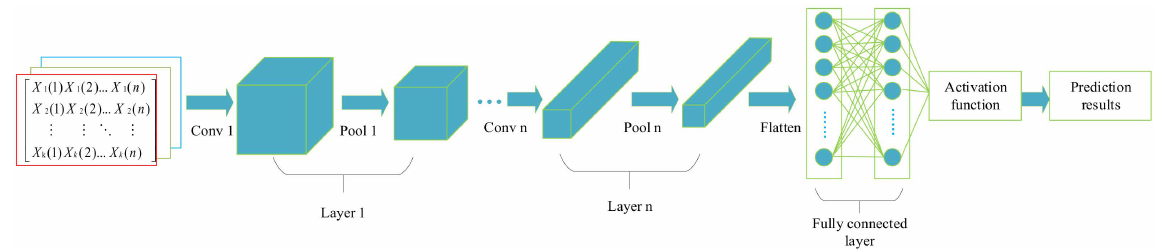
Figure 1. Structure diagram of a CNN.